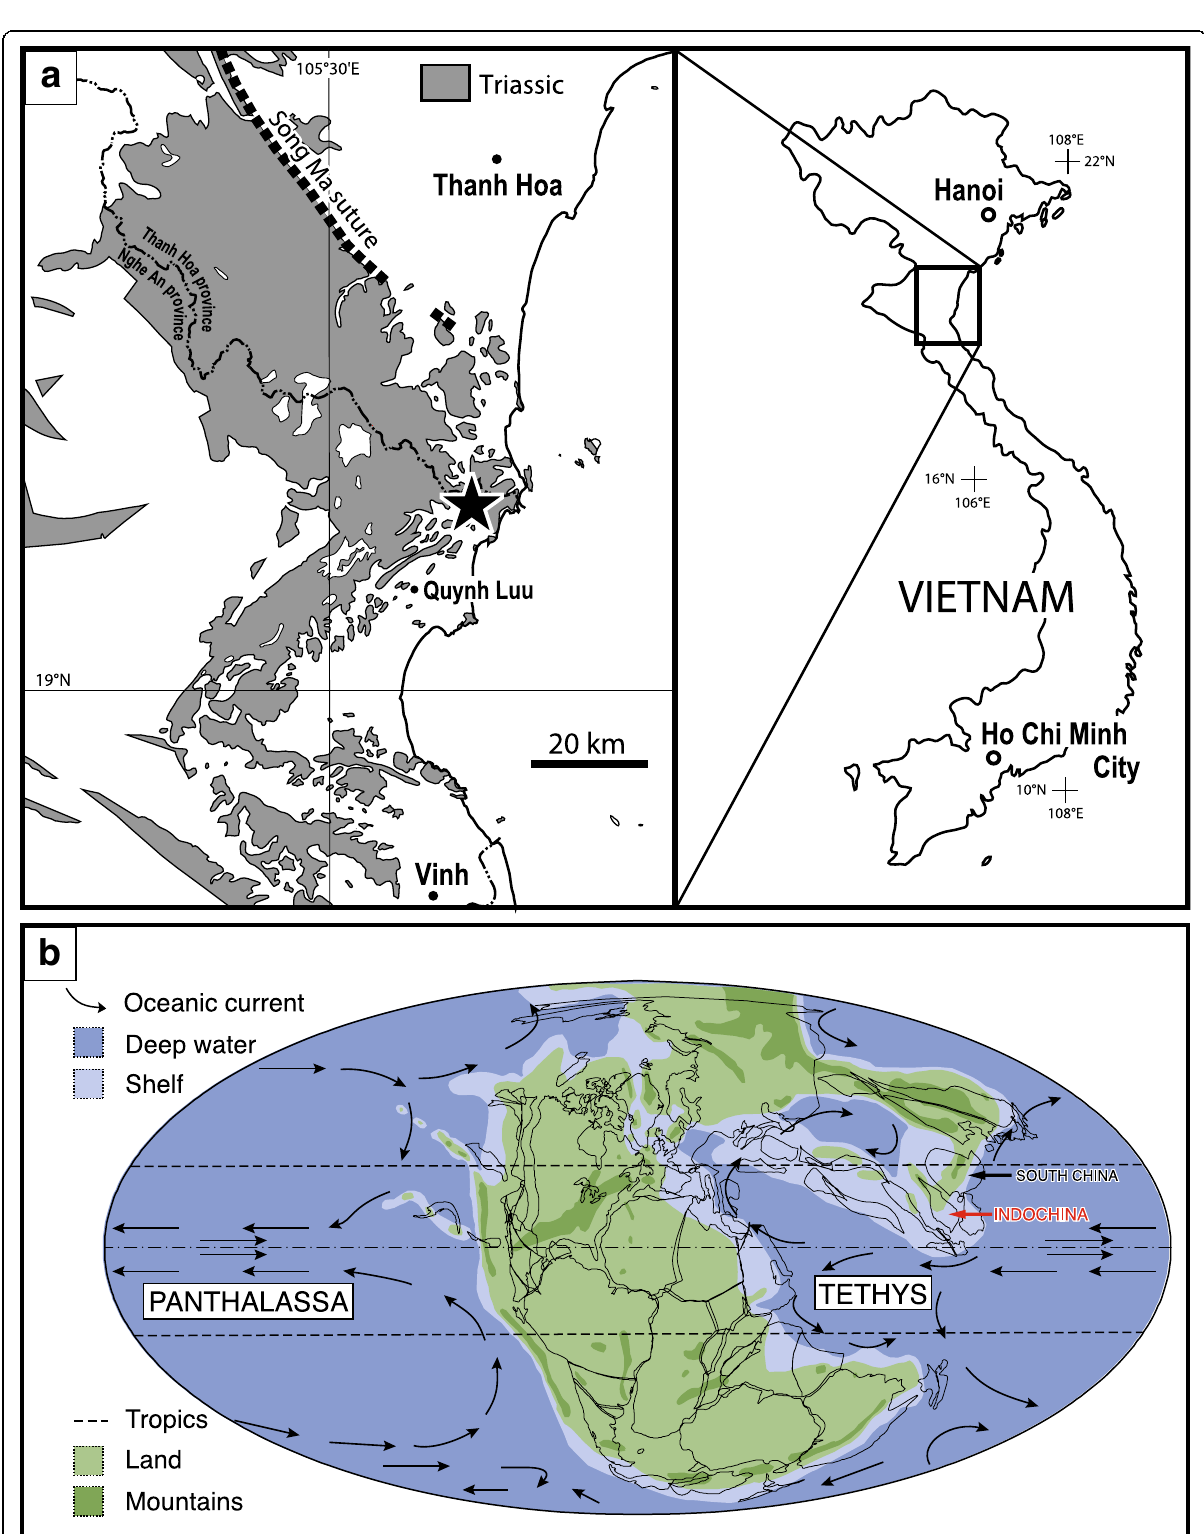
Fig. 1 Location of the study site. a Maps showing the study site. b Paleogeographic map of the Late Triassic (modified from Martindale et al.